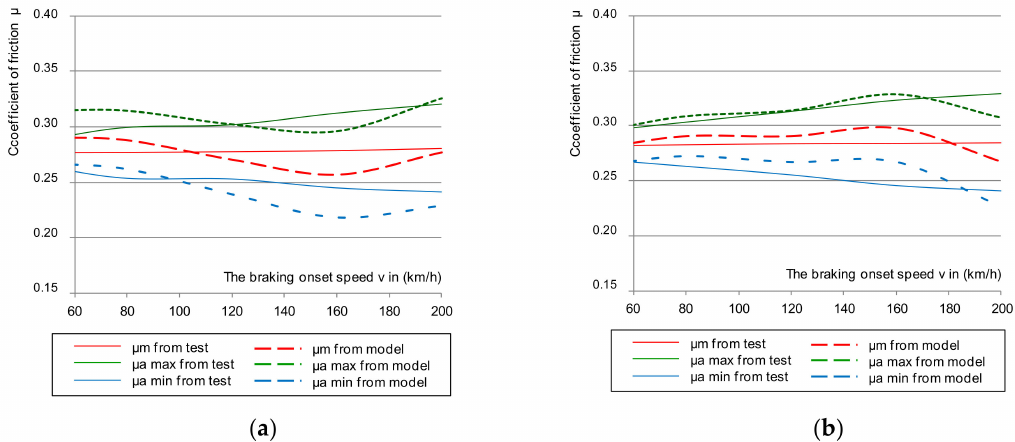
Figure 13. The changes in µ m from the tests with multiple regression model during braking on the G 2 lining with N = 25 kN, M = 5.7 t for ( a ) smooth disc and ( b ) perforated disc.